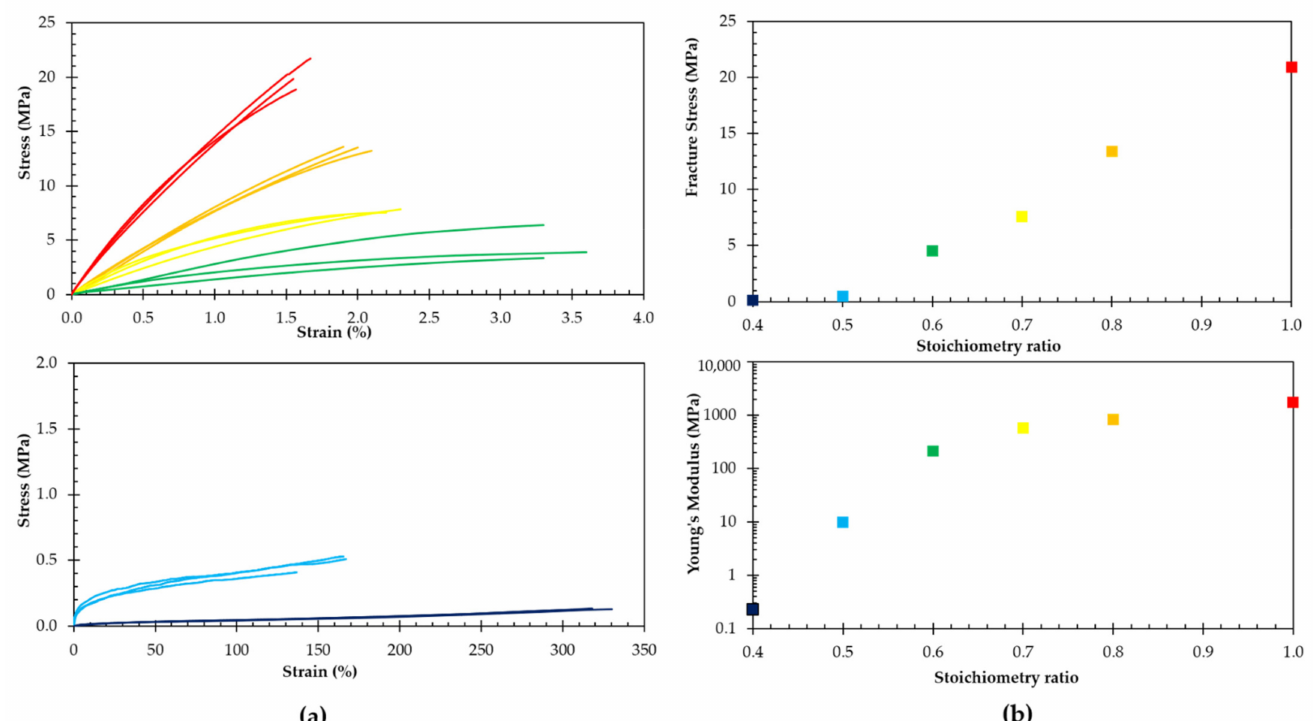
Figure 4. ( a ) The stress–strain curves of DPBM-F400 ( r = 1) red, ( r = 0.8) orange, ( r = 0.7) yellow, ( r = 0.6) green ( top ), and ( r = 0.5) light blue, ( r = 0.4) dark blue ( below ) in tension mode at a 1% min − 1 strain rate; ( b ) fracture stress ( top ) and Young’s Modulus ( below ) as a function of stoichiometric ratio r of synthesized